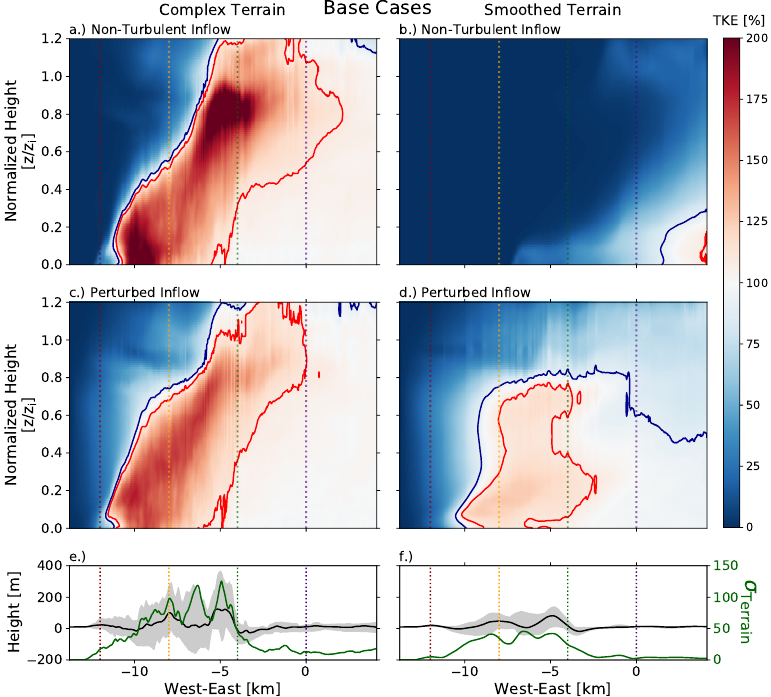
Figure 15. Panels ( a – d ) show the percentage of time-averaged TKE averaged along the y -direction with normalized height for the Base cases. Dark blue lines contour the 90th-percentile and red lines contour the 110th-percentile. Panels e and f show the y -average of terrain height (black line) with the maximum and minimum of terrain heights (filled gray) on one axis and the variance of terrain height along the y-direction (green) on the opposite axis. Panels ( a , c , e ) (left column) show fields for simulations over complex terrain. Panels ( b , d , f ) (right column) show fields for simulations over smoothed terrain. Panels a and b show results for non-turbulent cases, while c and d show results for the perturbed cases. See text for detailed